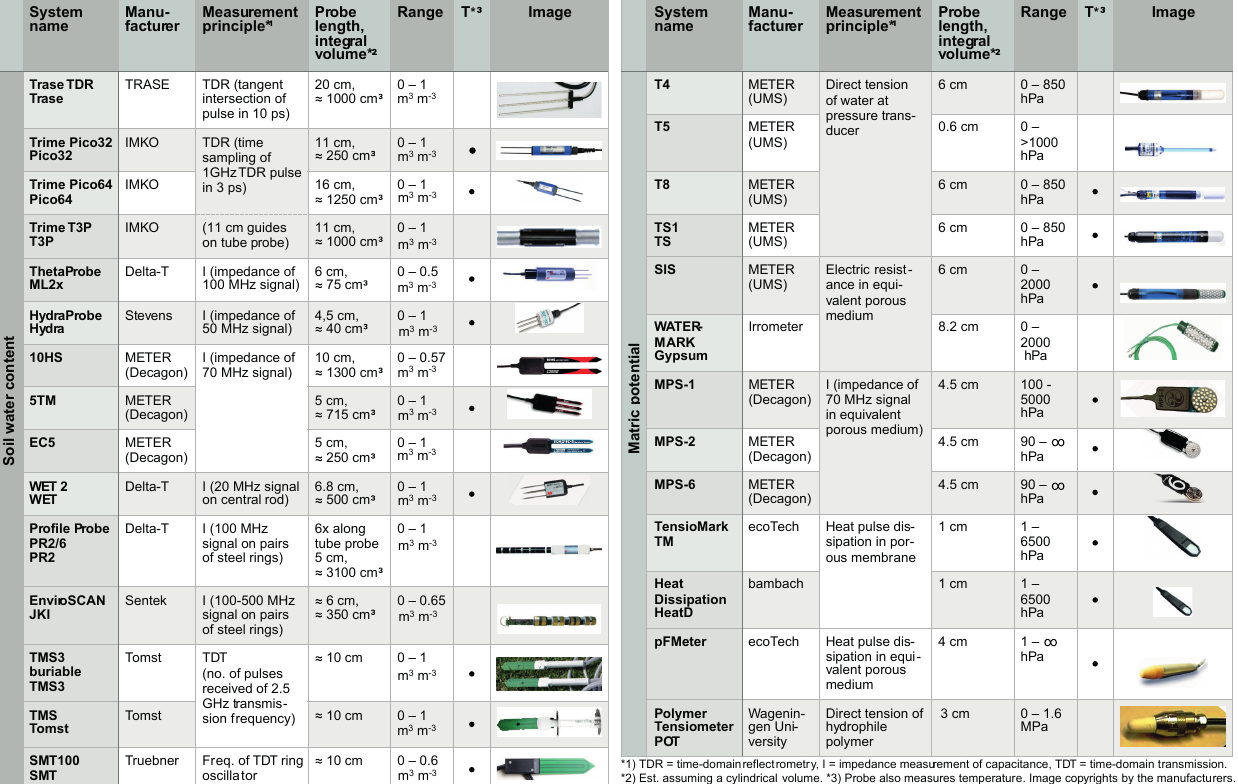
Table 1. Employed sensor systems in the comparison study. All information according to the respective